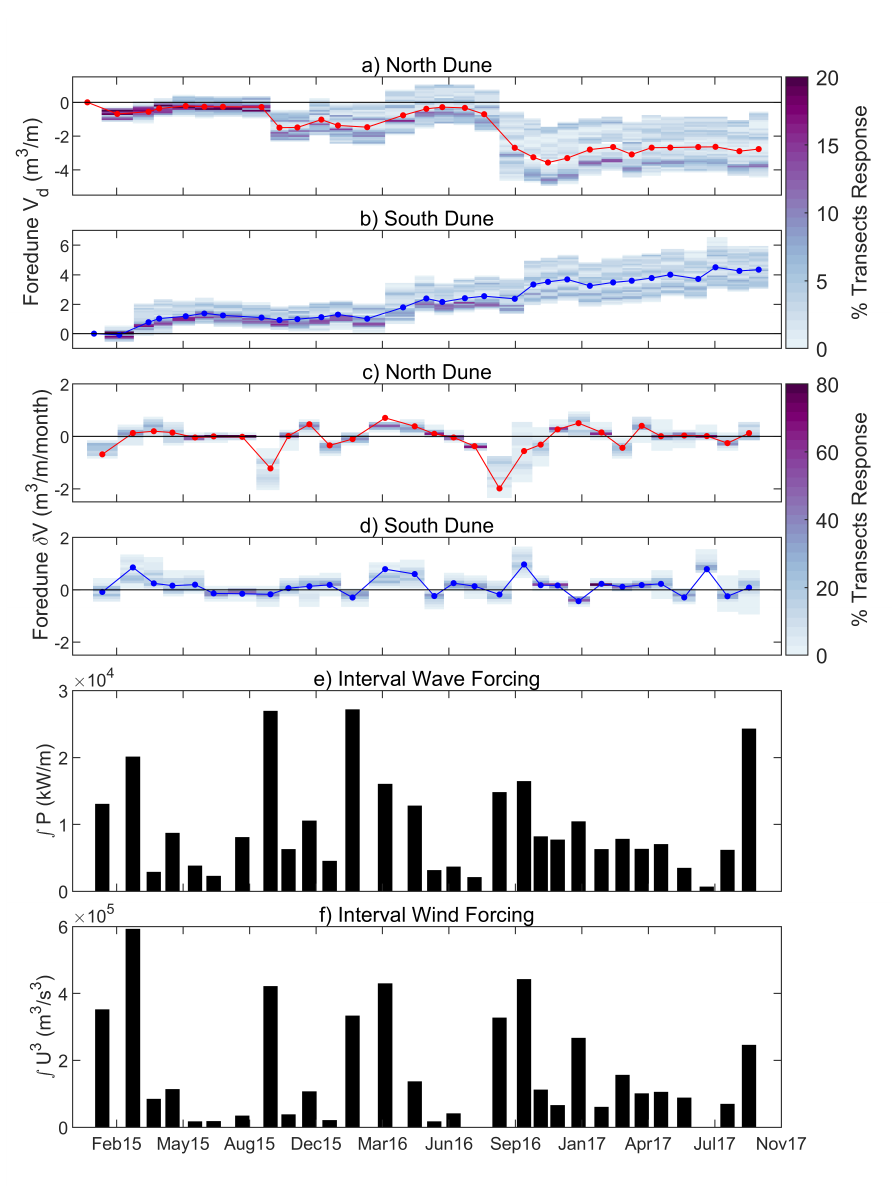
Figure 7. Temporal evolution of both sites over the course of the study. ( a , b ) Interval foredune volume, V d , relative to the first survey and ( c , d ) foredune volume change rate, δ V d , through time, for the north and south sites, respectively. Colors show the spatial distribution within the site, and filled circles show the alongshore-averaged quantities, V d and δ V d . ( e , f ) Integrated interval wave power ( (cid:82) U 3 ) verses time, velocity cubed (